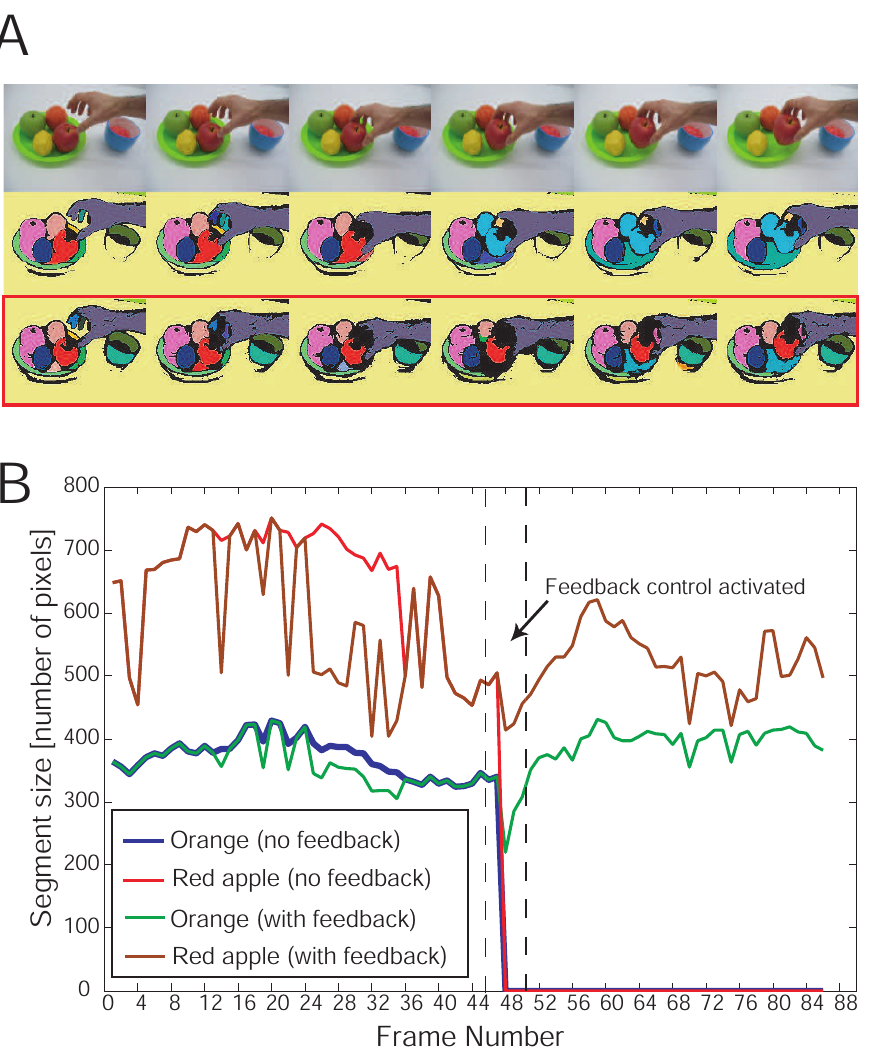
Figure 6. Feedback control for segmentation stabilization. A A few frames of a movie showing a hand taking a red apple from a plate are shown together with the results of the core algorithm without and with feedback control (upper, middle, and lower panel, respectively). B The segment size is plotted as a function of the frame number for the segments representing the red apple and the orange without and with feedback control, depicted as red, blue, brown and green lines, respectively. At frame number 45 the segment sizes of the red apple and the orange drop unexpectedly to zero (red and blue lines), and the feedback control is activated, increasing the temperature T until the original segments are recovered (brown and green